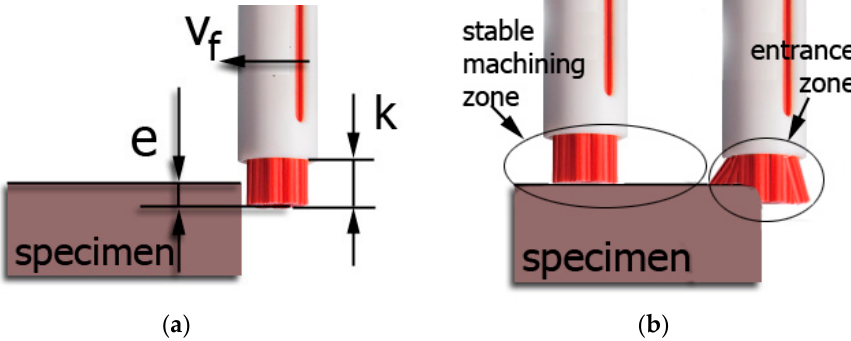
Figure 4. Brushing process: ( a ) graphical representation of infeed “e” and fibre projection length from sleeve “k”; ( b ) machining zone presentation.